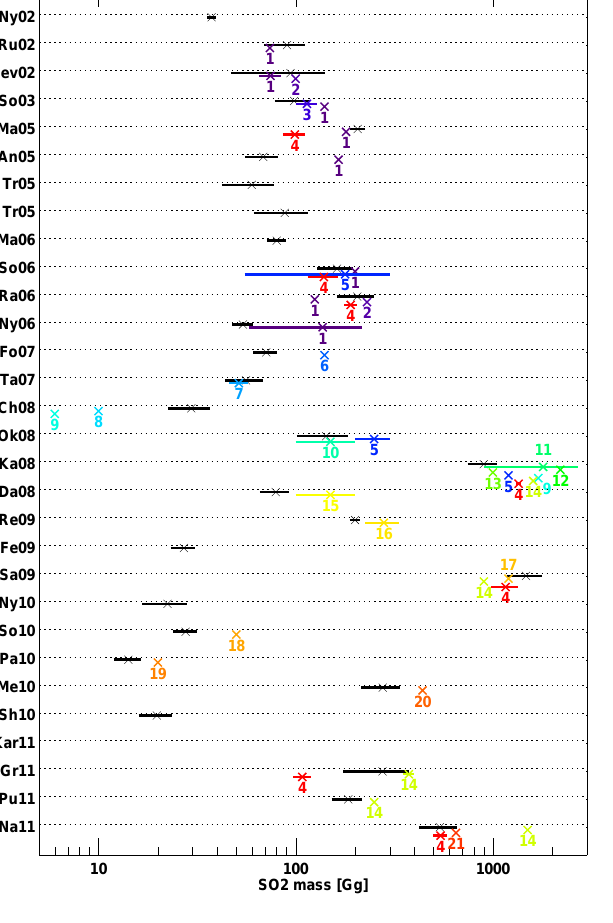
ratios of SO 2 are around 40–50 pptv. An annual cycle of SO